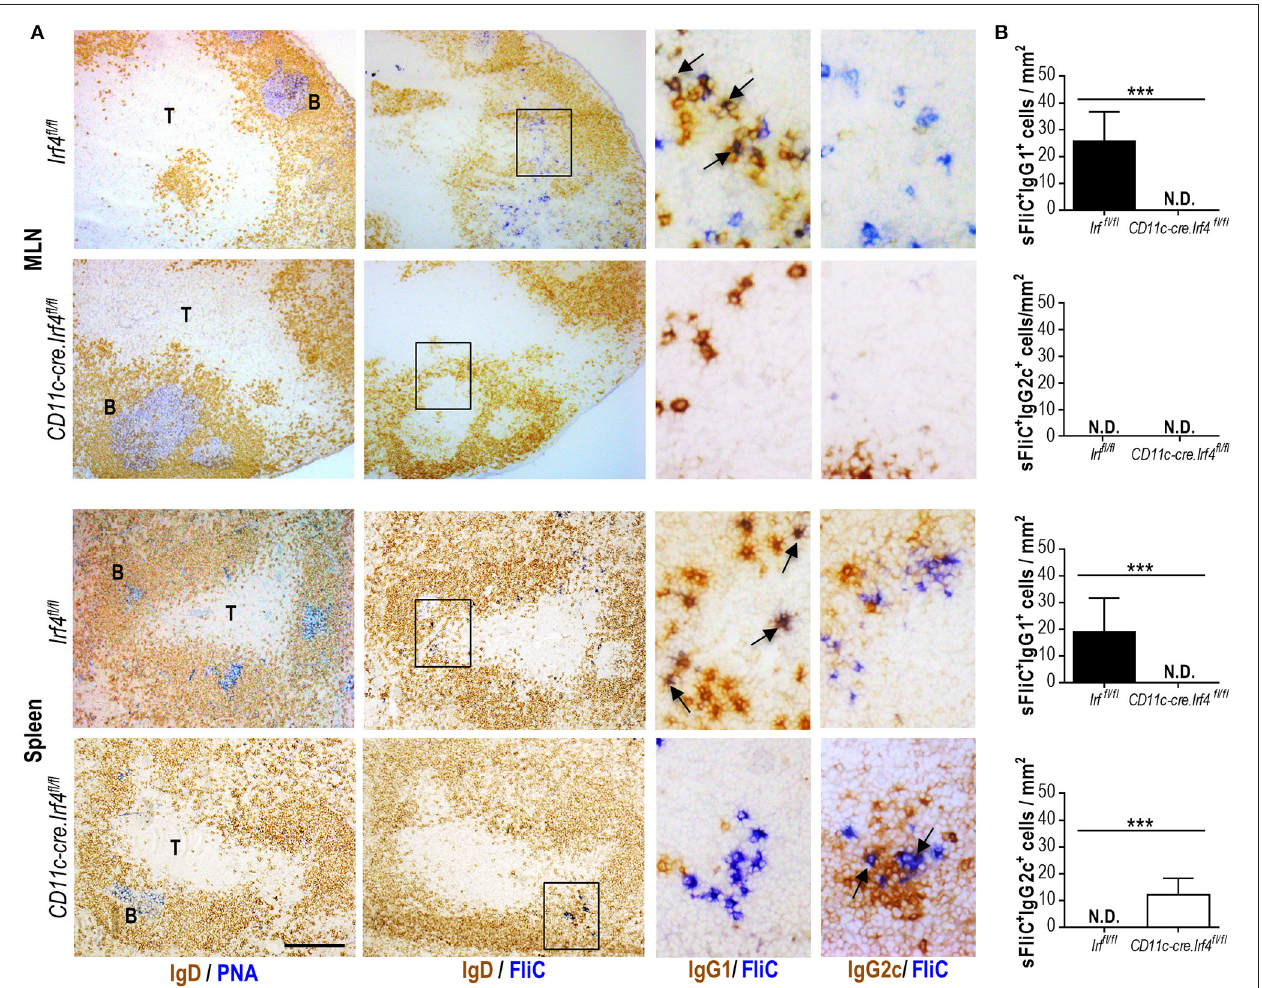
FIGURE 4 | Switching to IgG1 is abrogated in the CD11c-cre.Irf4 fl / fl mice. Irf4 fl / fl or Cd11c-cre.Irf4 fl / fl mice were sFliC-immunized for 7 days. (A) Representative photomicrographs of serial sections from MLN and spleen stained for: PNA-binding cells (blue) and IgD-expressing cells (brown) (first column) or sFliC-binding cells (blue) and IgD-expressing cells (brown) (second column), scale bar = 200 µ m. The third and fourth columns show zoom-in insets (black-boxed areas) stained to detect sFliC-binding cells and IgG1 and IgG2c respectively (scale bar = 50 µ m). T, T zone; B, B zone. (B) Quantification of sFliC + IgG1 + cells and sFliC + IgG2c + cells in the MLN and spleen. A total of 10 random fields were evaluated per slide. Data shown as mean + s.d. ( n = 8 mice pooled from two independent experiments). *** P < 0.0001, by Mann-Whitney. N.D.